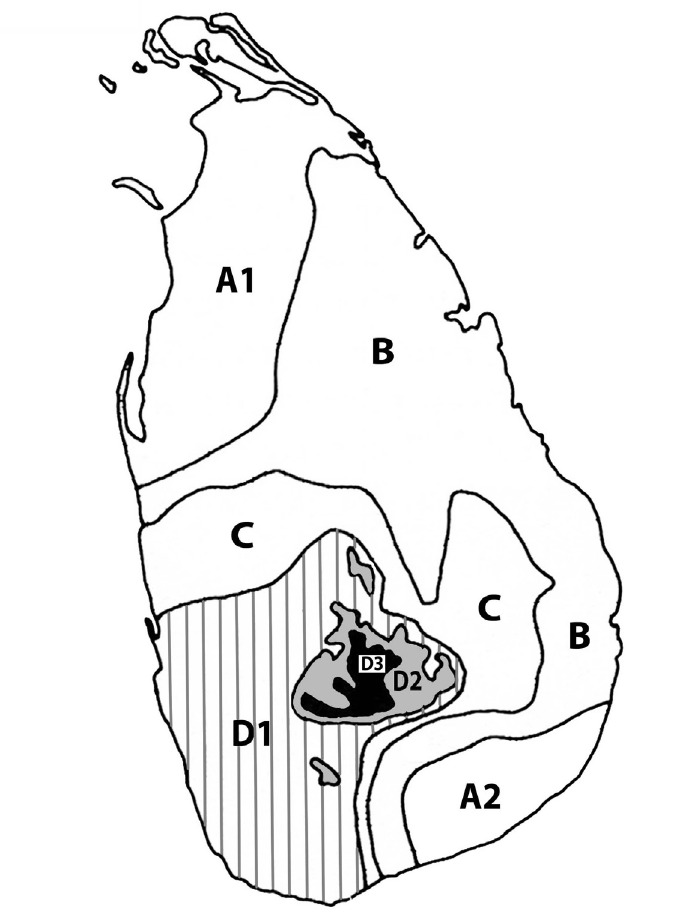
Figure 3: The climatic zones of Sri Lanka are: arid lowlands (A1 and A2), dry zone lowland (B), intermediate zone (C), rainforests of the lowland (D1, striped), midland (D2, dark gray) and montane regions (D3,